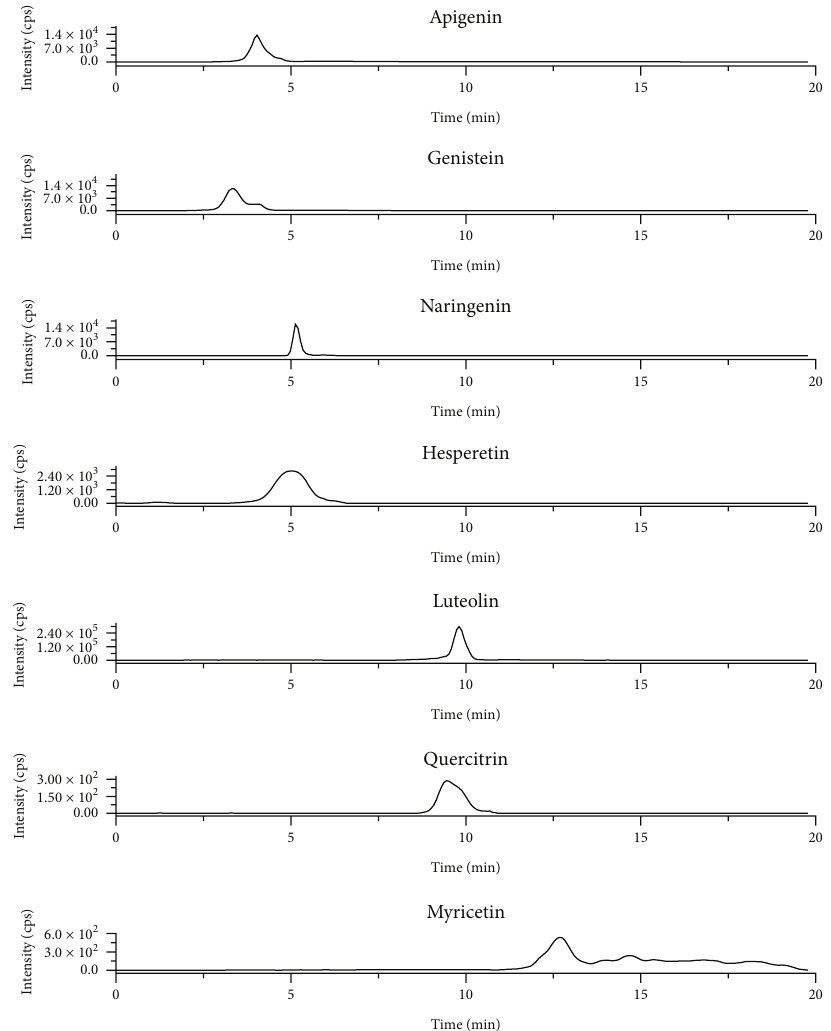
Figure 5: ESI-MS spectra of selected compounds in the Genista tinctoria extract. Column: ZIC-HILIC (100 × 2.1mm, 3.5 𝜇 m). Elution gradient: 0–4 min 98% ACN, 6-7min 90%, 8–8.4 min 80%, 8.4–12 min 50%, and 13–20 min